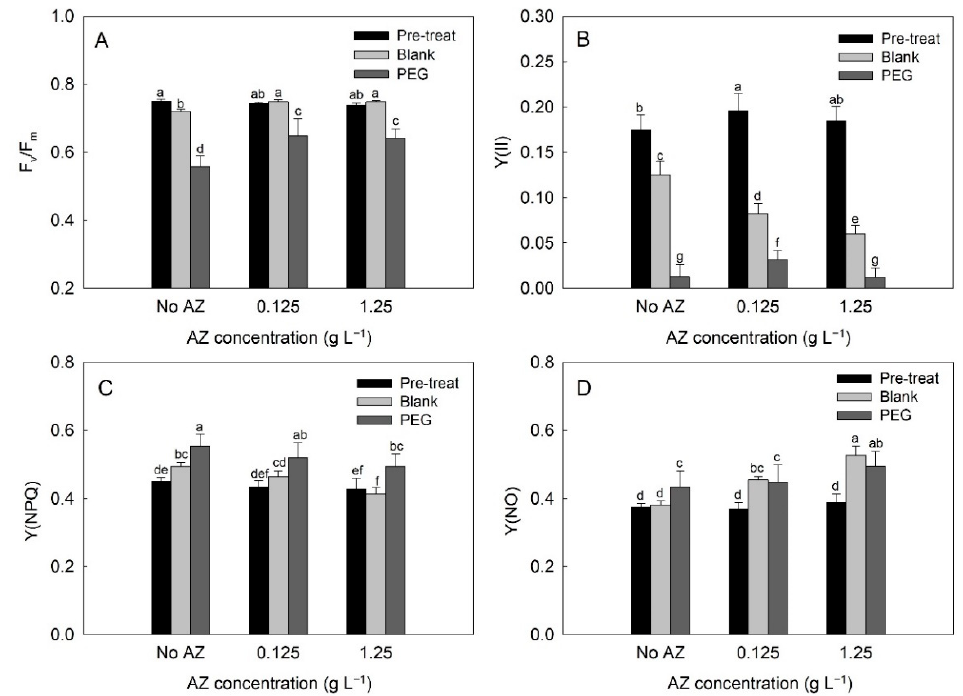
Figure 6. Change in the maximum quantum yield of PSII (F v /F m ) ( A ) , actual photosynthetic efficiency of PS II (Y(II)) ( B ), quantum yield of regulated energy dissipation (Y(NPQ)) ( C ), and quantum yield of non-regulated energy dissipation (Y(NO)) ( D ) value of tea leaf discs with pre-treatment (Pre-treat) of three different azoxystrobin (AZ) levels and then treated by blank solution (Blank) and PEG-induced osmotic stress (PEG), respectively. Values are the means ( n = 5) with standard errors shown by vertical bars. Different letters (a–g) represent statistically different means (LSD, p < 0.05). Y(II) in leaf discs with 0.125 g AZ L − 1 (0.20) was significantly higher ( p < 0.05) than with-